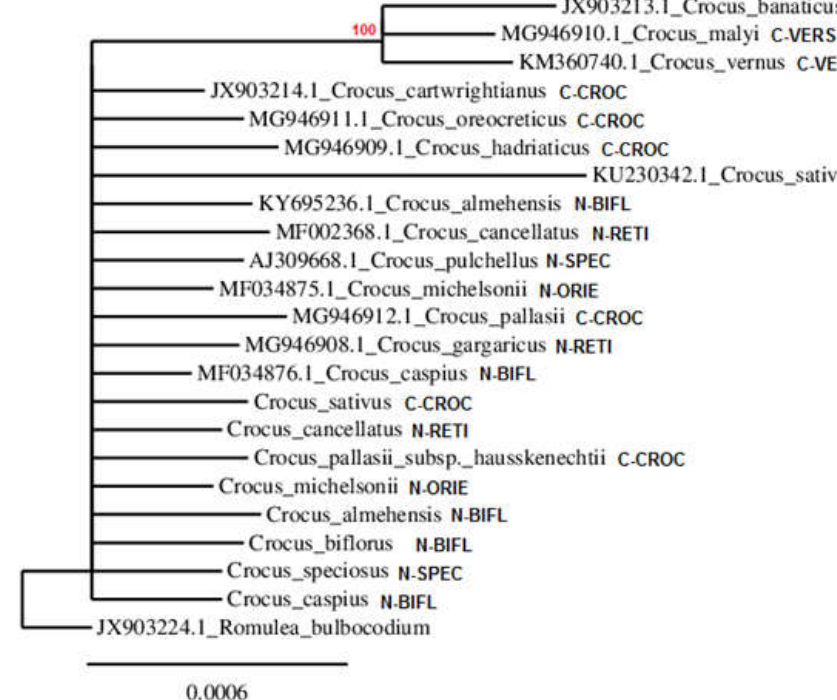
Fig. 3. The phylogenic tree derived from the analysis of rbc L region data by the Bayesian method, the number above each branch shows the bootstrap